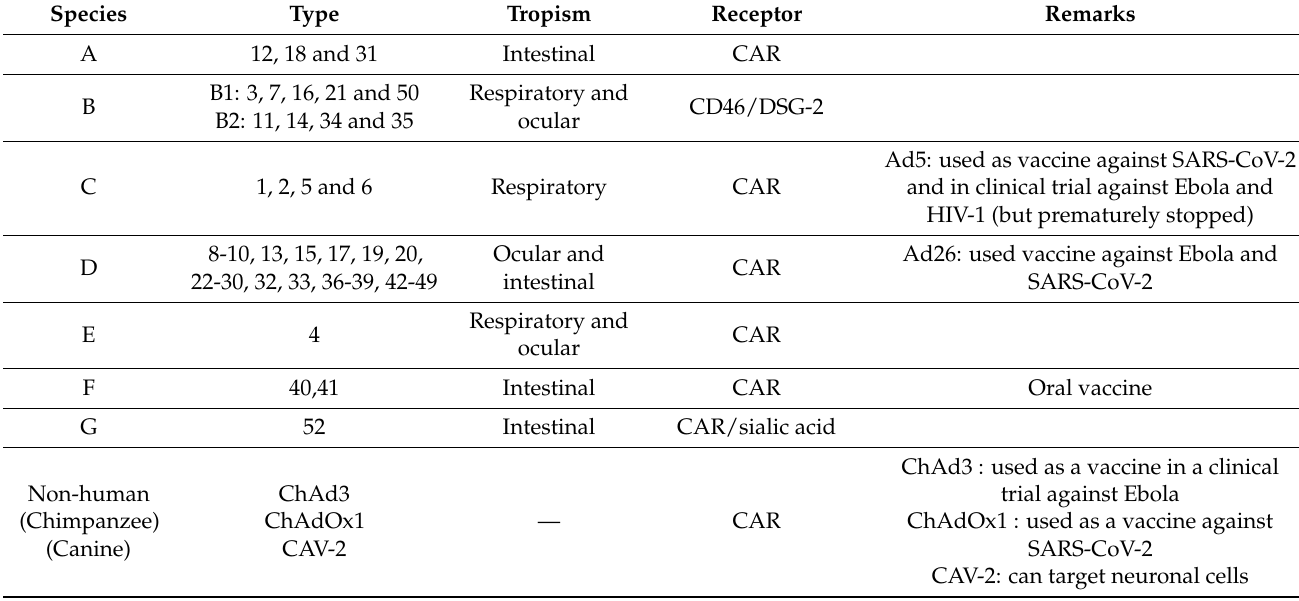
Table 1. A simplified overview of human Ads and non-human Ads and their uses for vaccination purposes. Species of human Ads, their receptor, and main